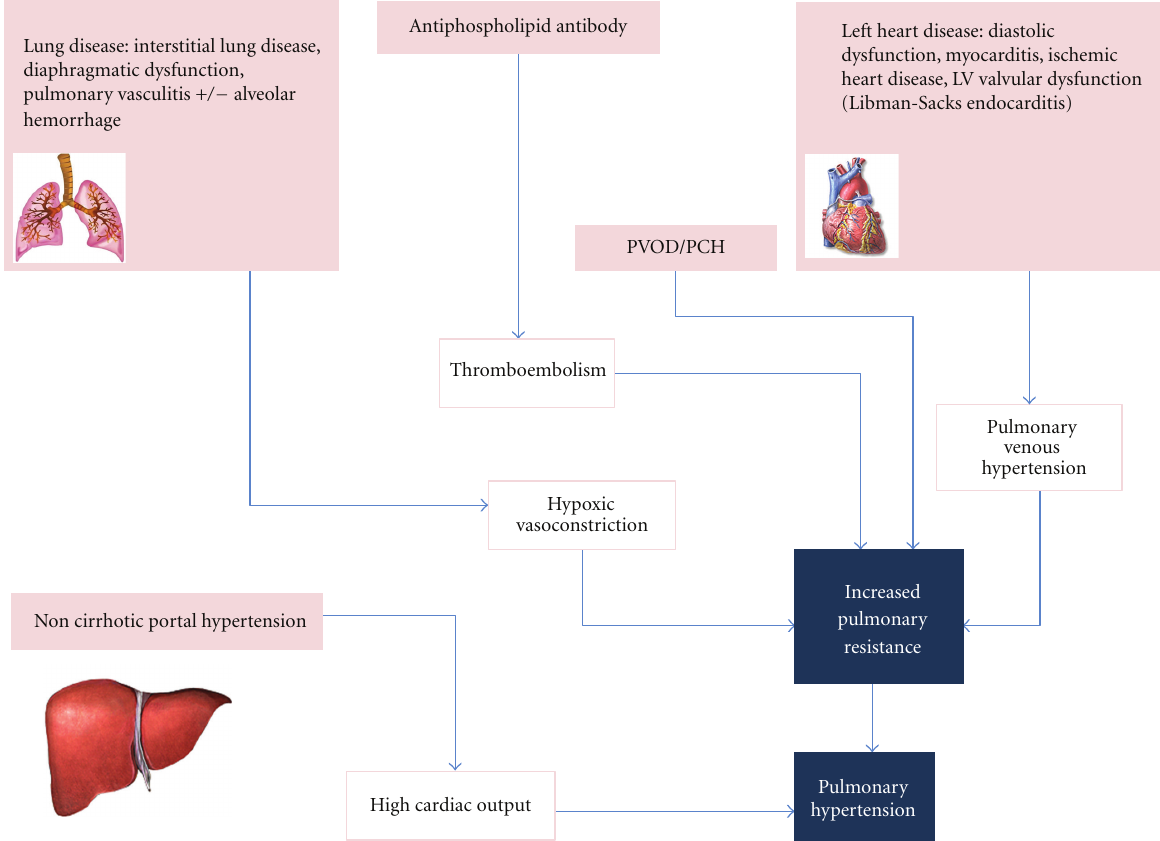
Figure 1: Pathophysiology of pulmonary hypertension in systemic lupus erythematosus. Pulmonary venoocclusive disease (PVOD); pulmonary capillary hemangiomatosus (PCH); left ventricle (LV).